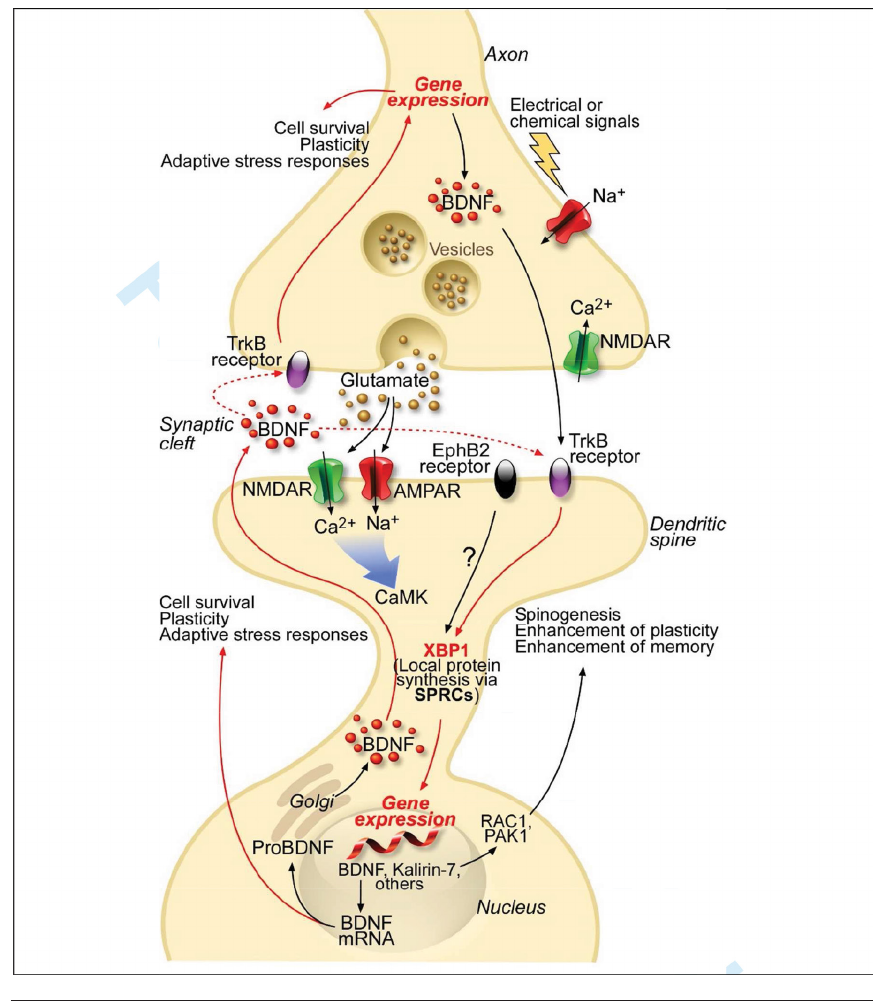
Figure 1. XBP1 signaling and neuronal plasticity. Presynaptic influx of Ca 2+ releases glutamate into the synaptic cleft. This activates AMPA, EphB2 and NMDA receptors at the postsynaptic membrane that engages CaMKs and induces the transcription of the Bdnf gene. In parallel, XBP1 can be locally synthetized within dendrites through SPRCs and transported into the nucleus to activate transcription of BDNF, Kalirin-7 and a myriad of other genes that are crucial for the survival and plasticity of neurons. mBDNF is released at synapses and activates TrkB receptors to recruit XBP1 and Kalirin-7, which controls spinogenesis through Rho-GTPases RAC1 and PAK1, resulting in a positive activation loop. BDNF signaling also regulates synaptic transmission through control of neurotransmitter release at presynaptic terminals. Abbreviations: AMPA(R), α -amino-3-hydroxy-5-methyl-4-isoxazolepropionic acid (receptor); BDNF, brain-derived neurotrophic factor; CaMK, Ca 2+ /calmodulin-dependent kinase; NMDA(R), N -methyl- D-aspartate (receptor); SPRCs, synapse-associated polyribosome complexes; EphB2, EphrinB2 receptor. Whether EphB2 acts upstream of XBP1 remains to be determined. Graphic adapted from